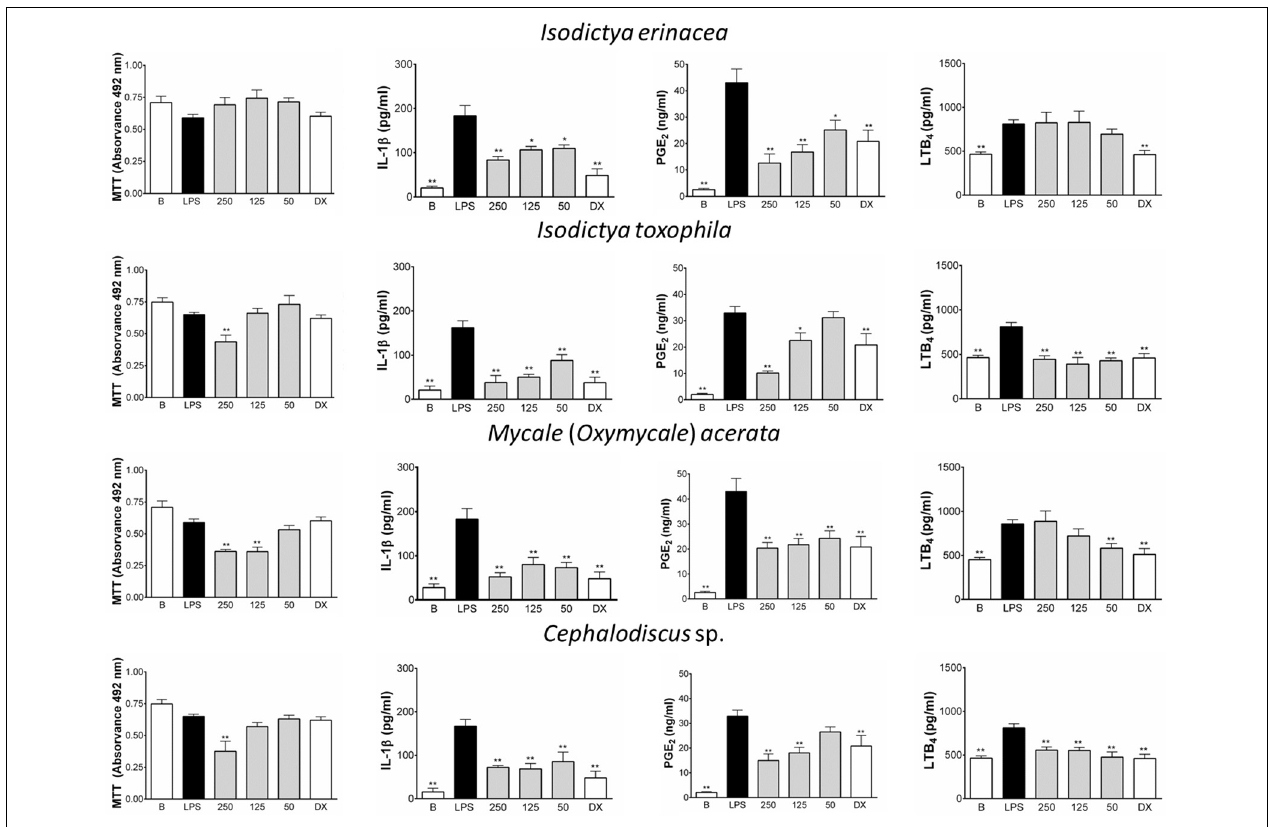
FIGURE 1 | Toxicity and anti-inflammatory effects of the extracts of Isodictya erinacea , I. toxophila , Mycale ( Oxymycale ) acerata , and Cephalodiscus sp. in the mouse macrophage cell line RAW 264.7. Cytotoxicity (MTT method) and amount of inflammatory mediators released: